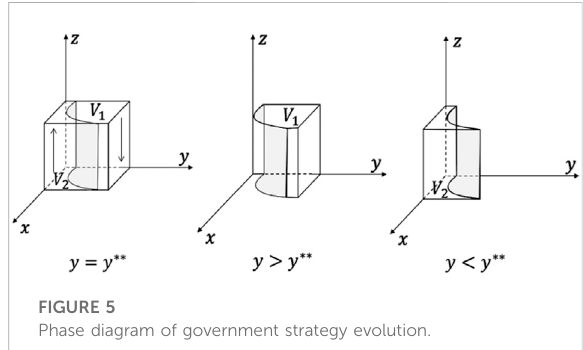
FIGURE 3 Phase diagram of power battery manufacturing enterprises strategy evolution.